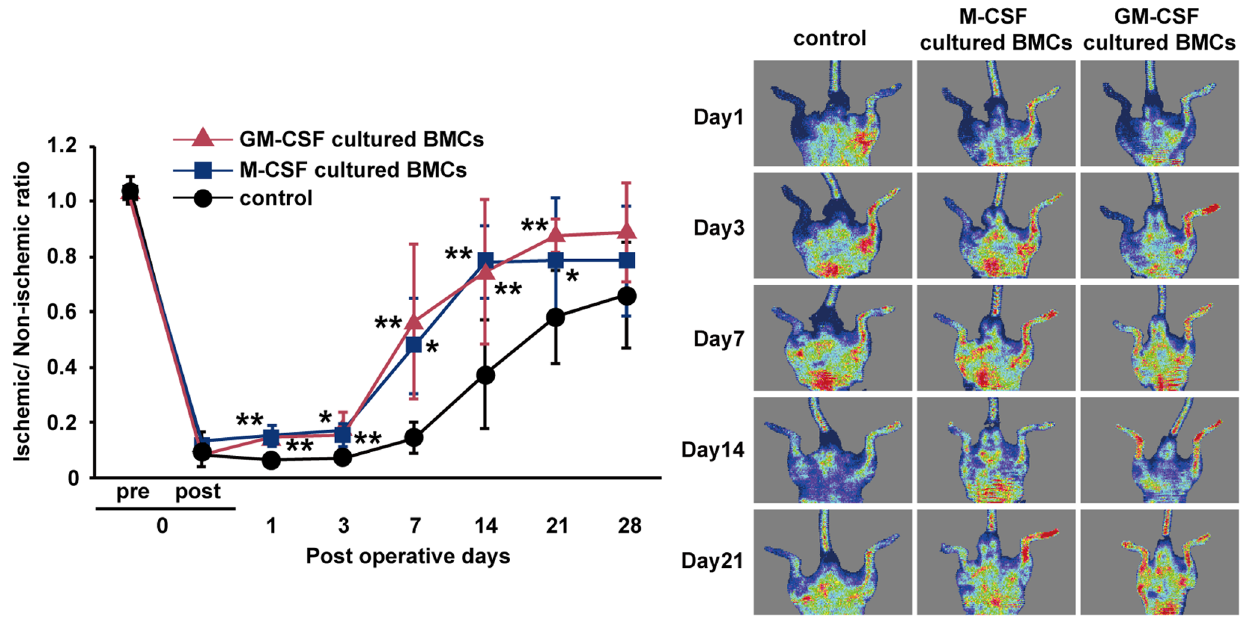
Figure 2. Recovery of blood flow in ischemic limbs treated with M-CSF-cultured BMCs and GM-CSF-cultured BMCs. Representative laser Doppler perfusion images taken at indicated intervals for the PBS control group, M-CSF-cultured BMCs group and GM-CSF-cultured BMC group. Data are expressed as mean 6 SEM, n=5–7/group, ** P , 0.01, * P , 0.05.